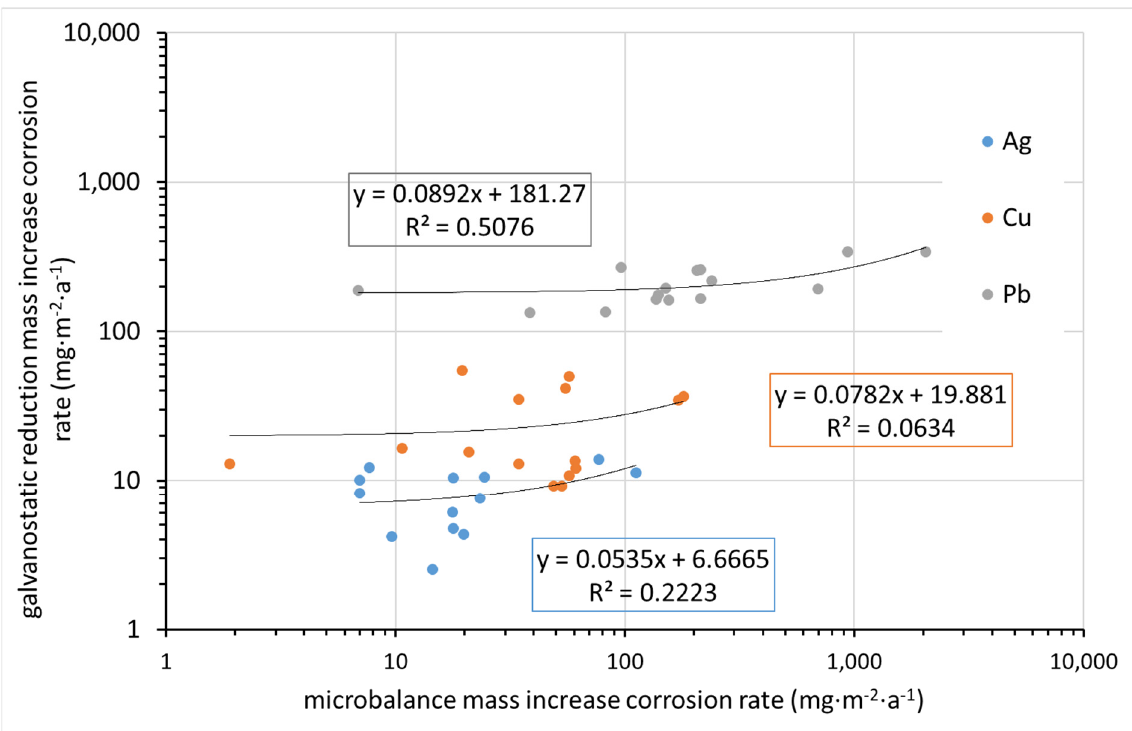
Figure 12. Comparison of corrosion rate after one year of exposure as obtained from microbalance mass increase and electrochemical galvanostatic reduction (in regression equations, y indicates galvanostatic reduction mass loss corrosion rate and x indicates microbalance mass increase corrosion rate).